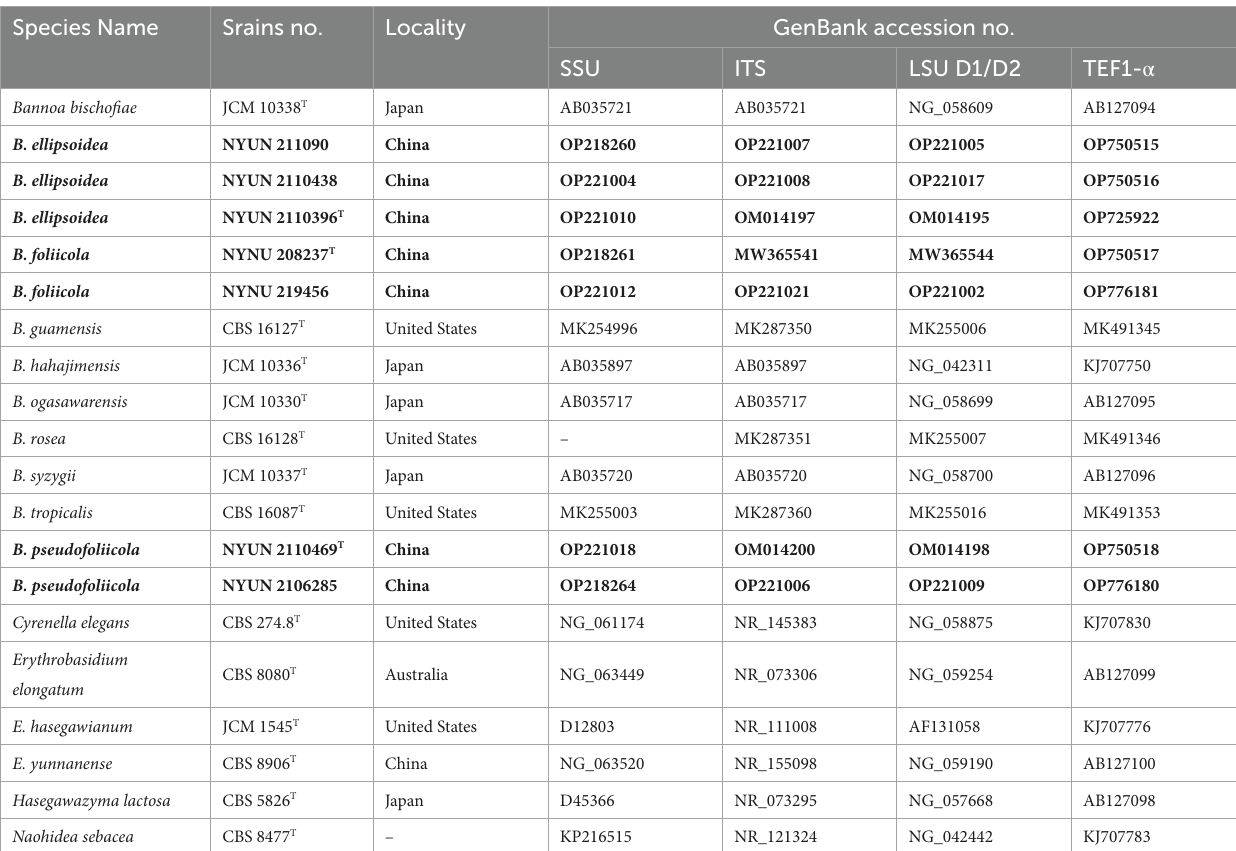
TABLE 2 Sequences used for the molecular phylogenetic analysis. Entries in bold were newly generated in this study. Species Name Srains